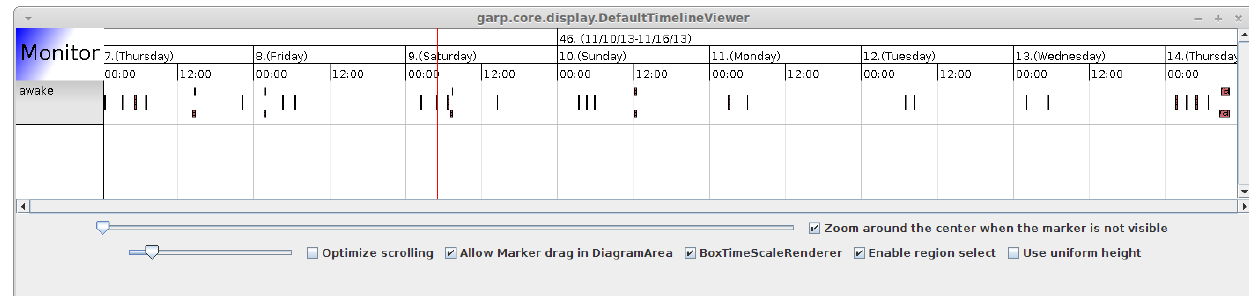
Figure 8. A timeline viewer showing the inference results from the query in Figure 8.